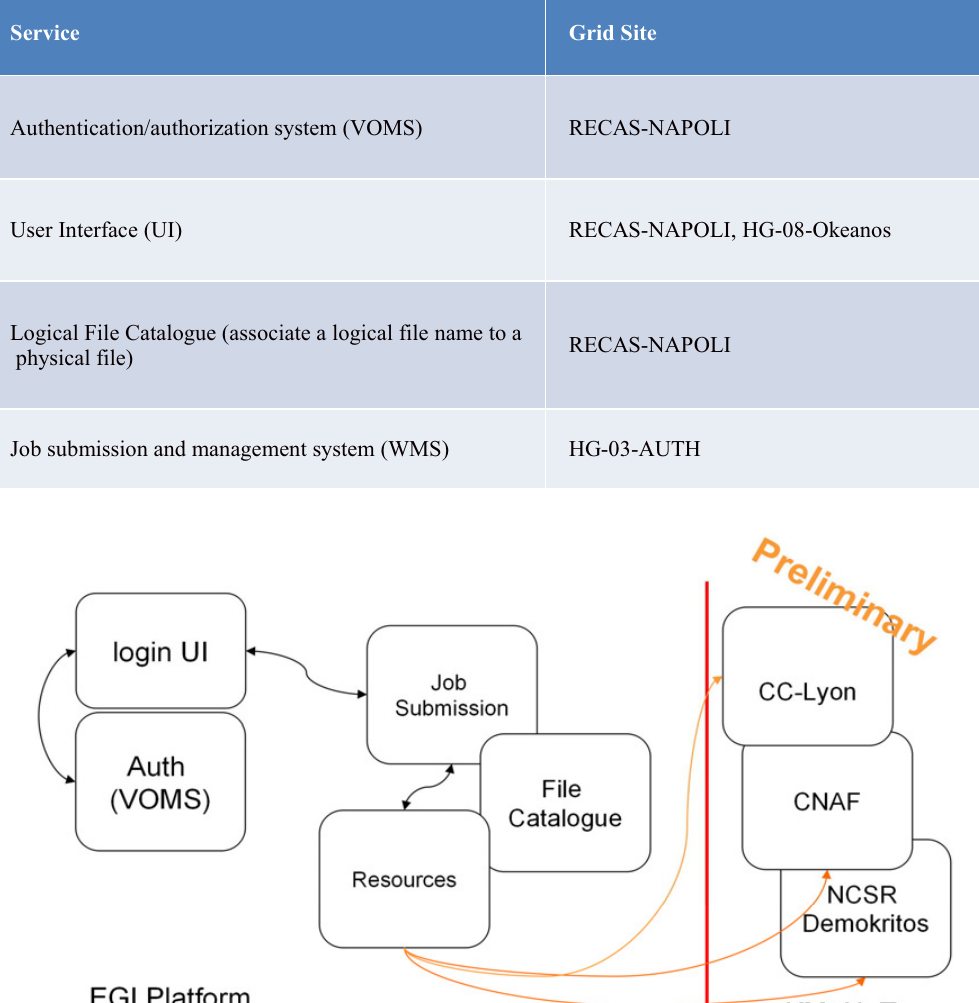
Table 2. KM3NeT.org VO central services.